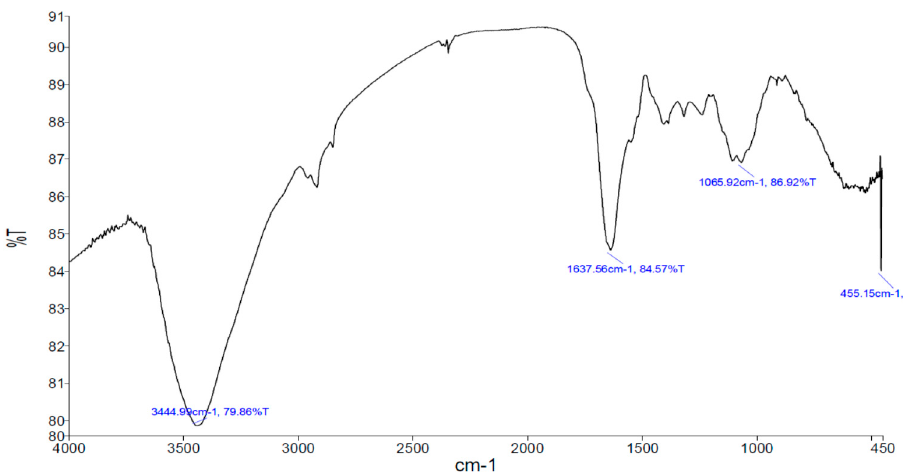
Figure 5. FT-IR spectrum of the M. oleifera leaves extract.